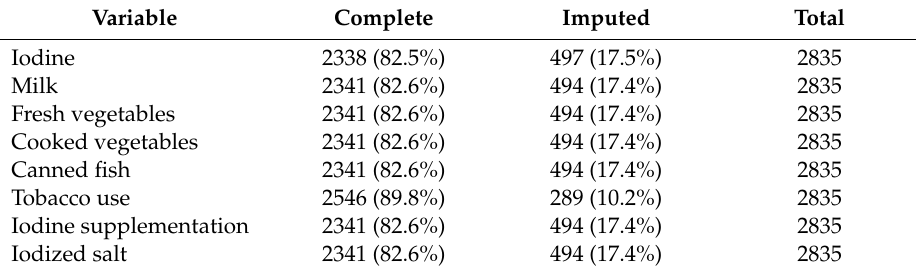
Table 5. Summary of the missing data